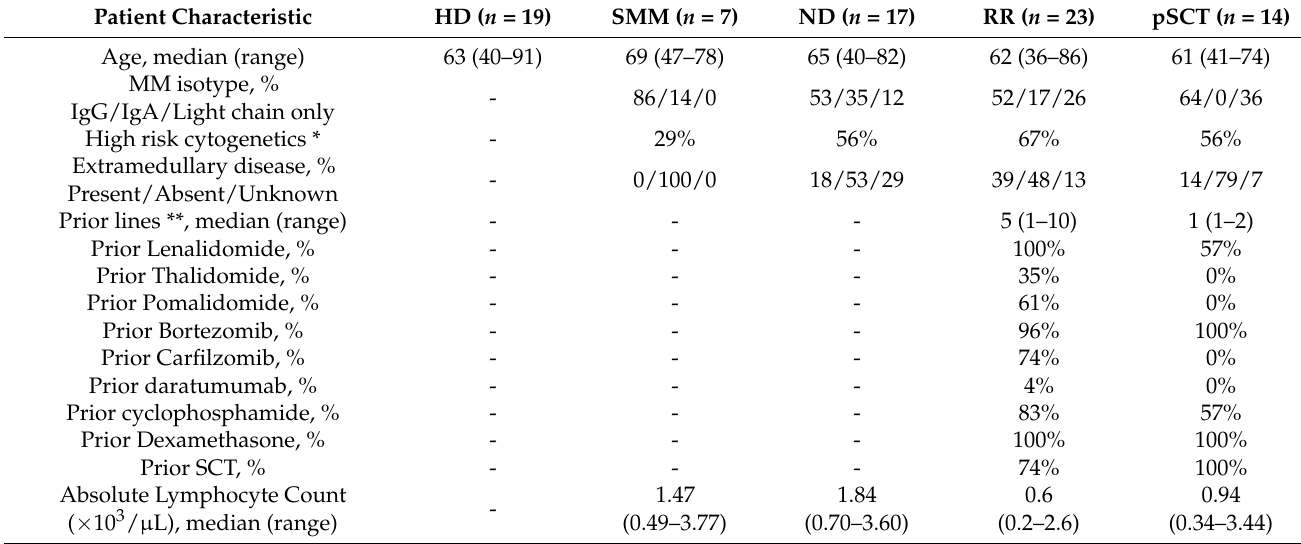
Table 1. Characteristics of patients and healthy